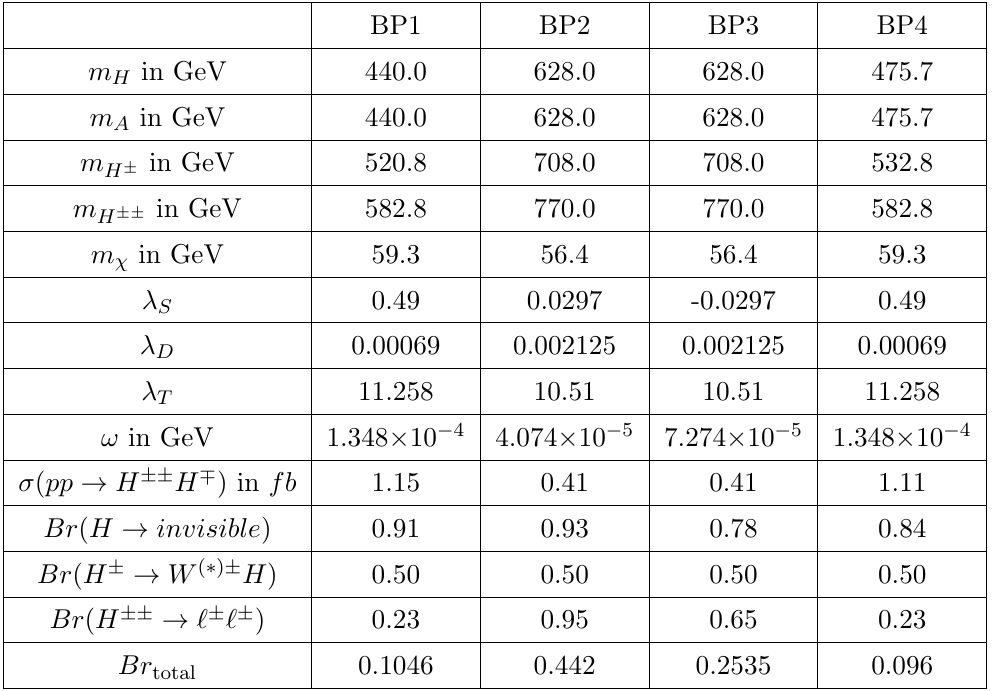
Table 1 . The Benchmark points for same-sign dilepton